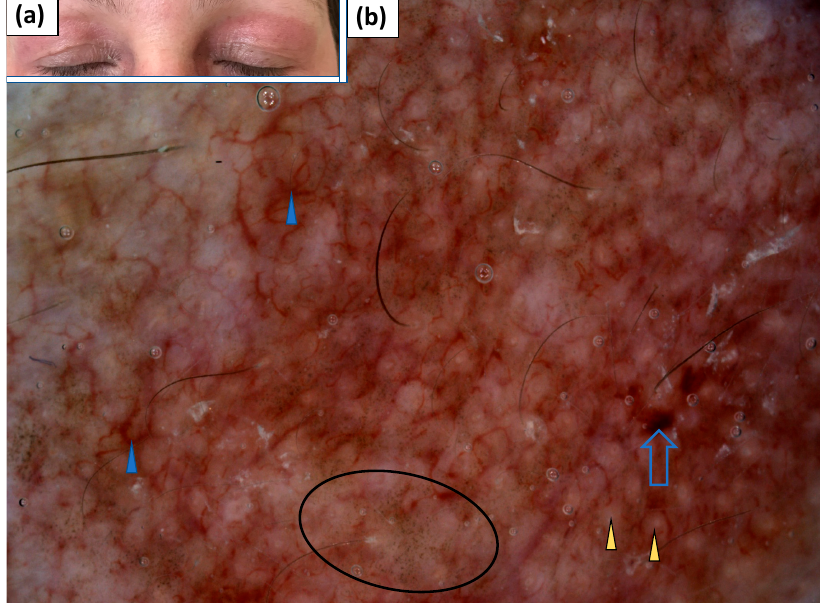
Figure 6. ( a ) Clinical presentation of heliotrope. ( b ) Videodermoscopy of heliotrope showed irreg- ularly distributed linear vessels with branches (blue arrowhead), red hemorrhagic globules (blue arrow), grey dots (black circle), and yellowish globules (yellow arrowhead). Less specific erythematous lesions on the face were noted in seven patients with DM.